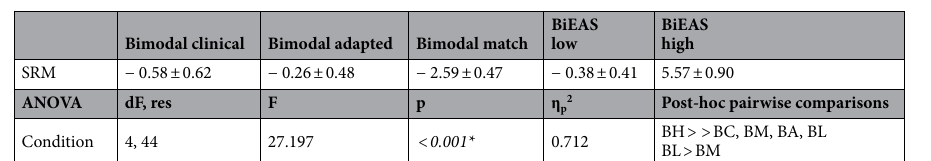
Figure 2. Boxplots of spatial release from masking (SRM) for the five listening conditions. The boxes show the 25th and 75th percentiles, the error bars show the 10th and 90th percentiles, the circles show outliers, the black line shows the median, and the red line shows the mean.